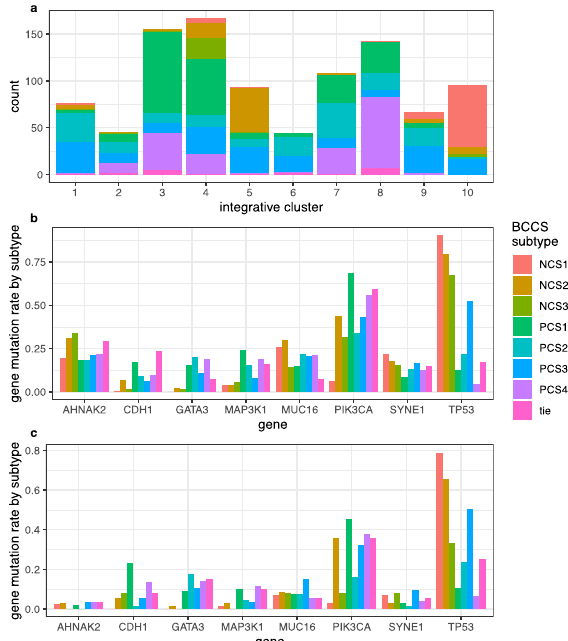
Fig. 6 Distribution of copy number changes and somatic mutations by BCCS subtype. The distribution by BCCS subtype of Integrative Cluster of copy number alterations in METABRIC-A is displayed in ( a ). Distribution by BCCS subtype of somatic mutations of AHNAK2, CDH1, GATA3, MAP3K1, MUC16, PIK3CA, SYNE1, TP53 is displayed for b METABRIC and c